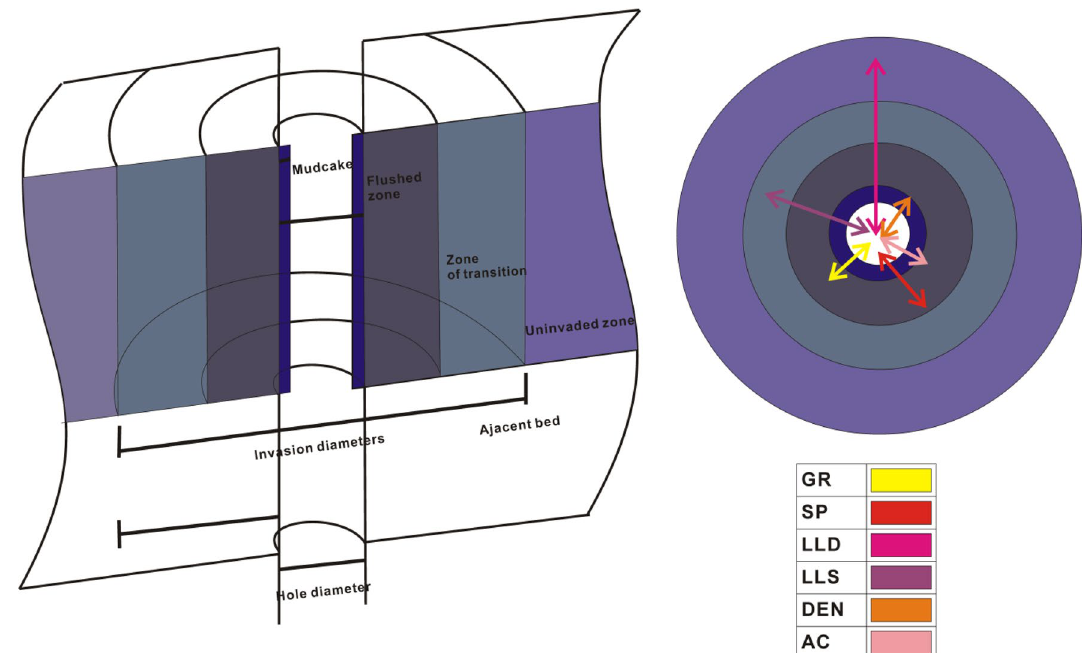
Fig. 18 Diagram of the intrusion characteristics of the reservoir and corresponding radial detection